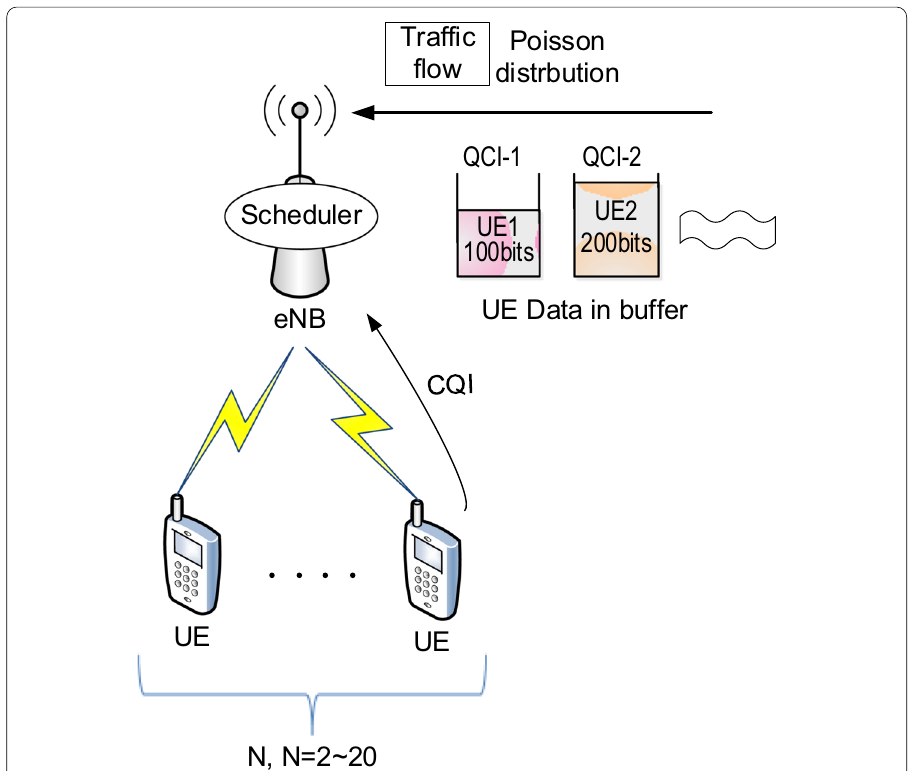
Fig. 8 Simulation architecture; The simulated network environment consists of one LTE‑A eNB and 20